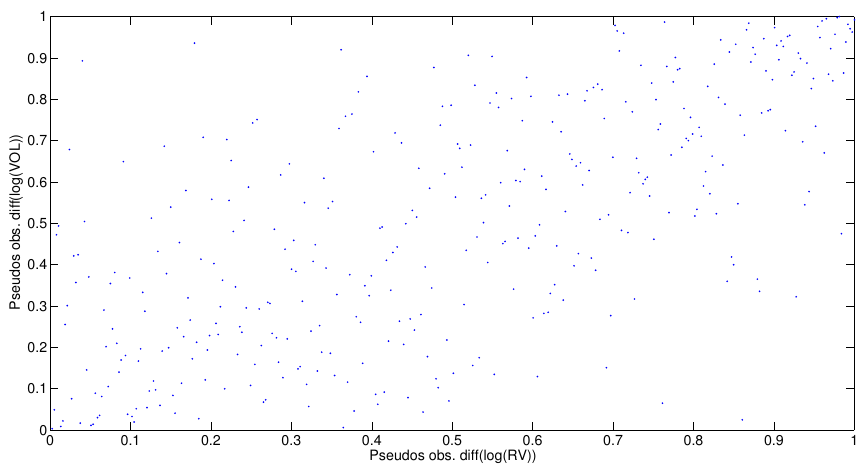
Figure 6: Scatter plot for the normalized rank of the first difference of the log of the realized volatility and the volume of trans-